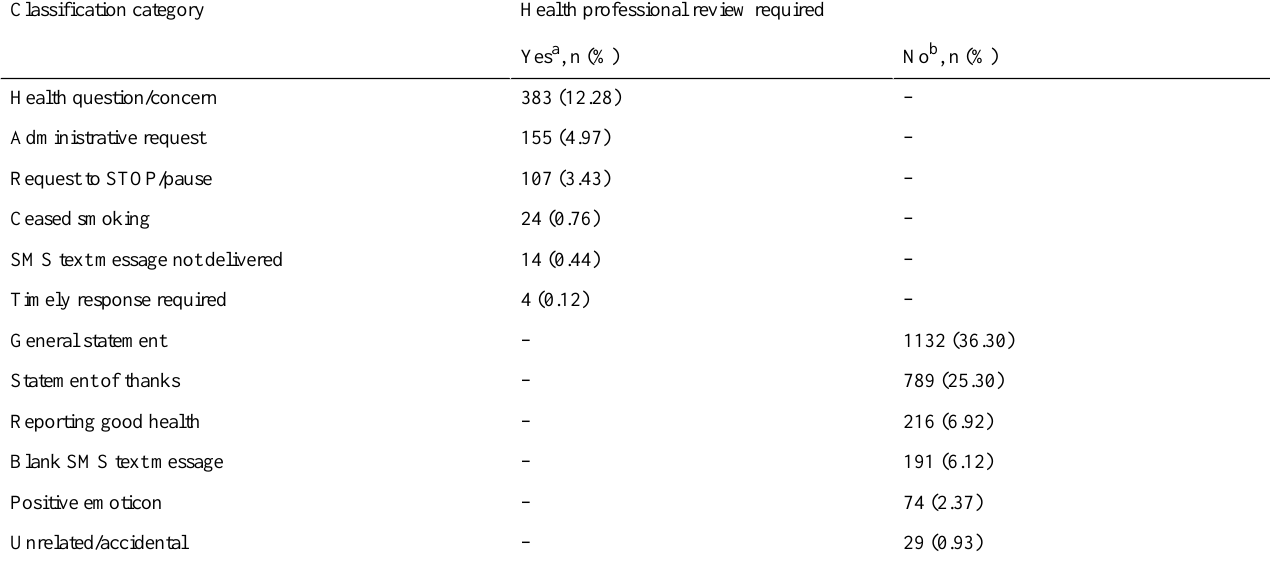
Table 1. Manual classification of SMS text messaging replies